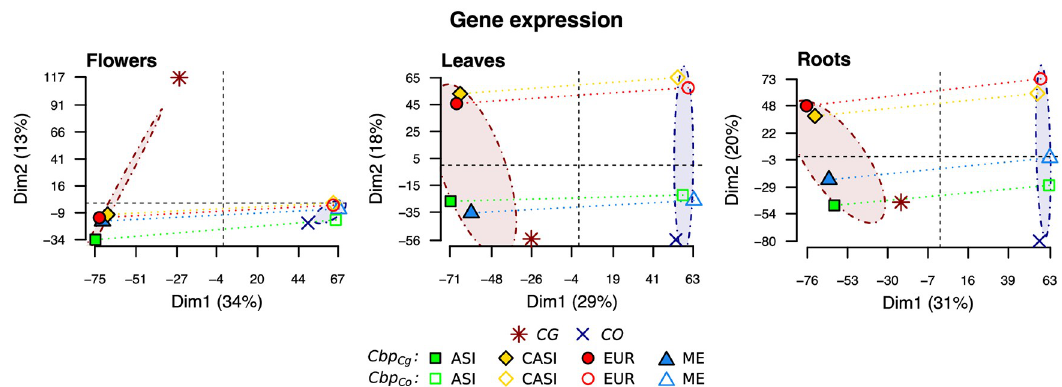
Fig 3. Transcriptomic variation patterns in three Capsella species. Variation was visualized with principal component analyses of phased gene expression data (11,931 genes) for the three different tissues. CO, CG, ASI, EUR, ME, and CASI correspond to C. orientalis , C. grandiflora , and four populations of C. bursa-pastoris , Cbp , (Asia, Europe, Middle East, and Central Asia), respectively. The dash-dotted circles highlight the two different subgenomes of Cbp